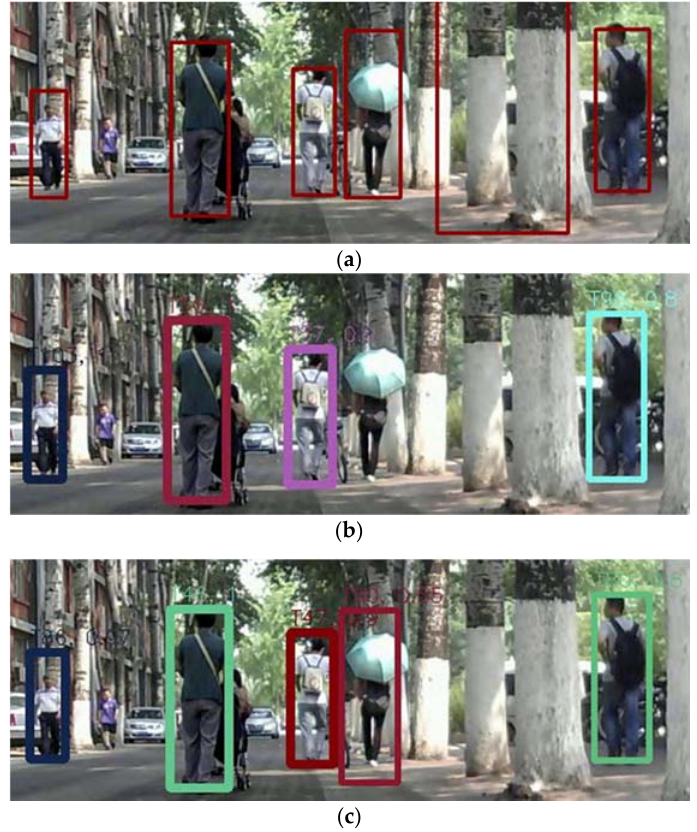
Figure 7. Comparison between RJMCMC and the proposed method with the video collected in our campus. ( a ) The detection results. A wrong detection result exists indicated by the largest bounding box. ( b ) The results of the RJMCMC method; the woman with umbrella is lost. ( c ) The good results of the proposed method.